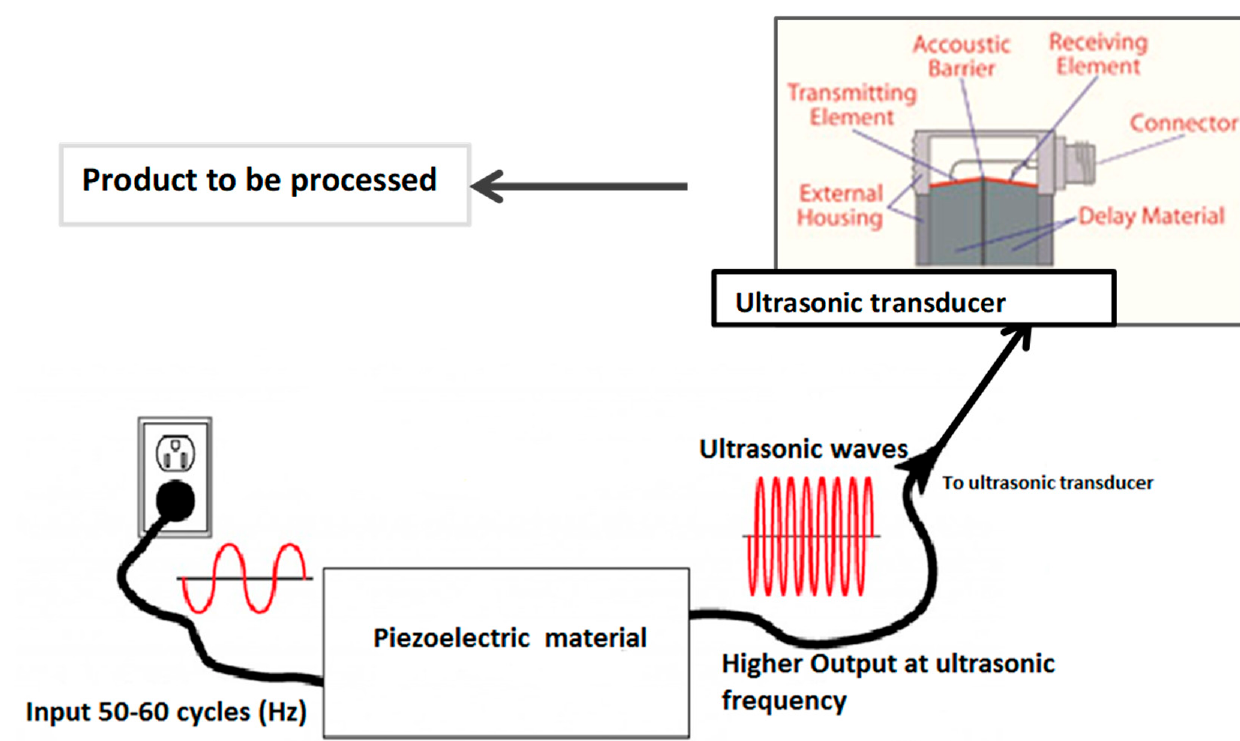
Figure 3. Assembly of ultrasound freezing technique. The turbulence caused by micro streaming has been used to enhance the heat and mass transfer process [70]. It can also be beneficial in the freezing process, reducing both the heat and mass transfer resistance at the ice/liquid interface, resulting in an increase in the freezing rate [71]. It was reported by Xin et al. [66] that relatively higher freezing rates can be achieved at relatively low ultrasound power levels. Higher ultrasound frequencies generate greater acoustic streaming, which, in turn, increases the rate of heat transfer, which results in a shorter freezing time. The ultrasonic vibration increases the fluid-to-particle convective heat transfer coefficient and is dependent upon ultrasonic power levels [72]. The absorption of ultrasonic power by the freezing solution causes a temperature increase. The rate of the temperature rise against the time of the ultrasound application can be measured calorimetrically to calculate the actual power transferred to the freezing solution during the sonication process. The power output dissipated (P) was calculated according to Equation (3):